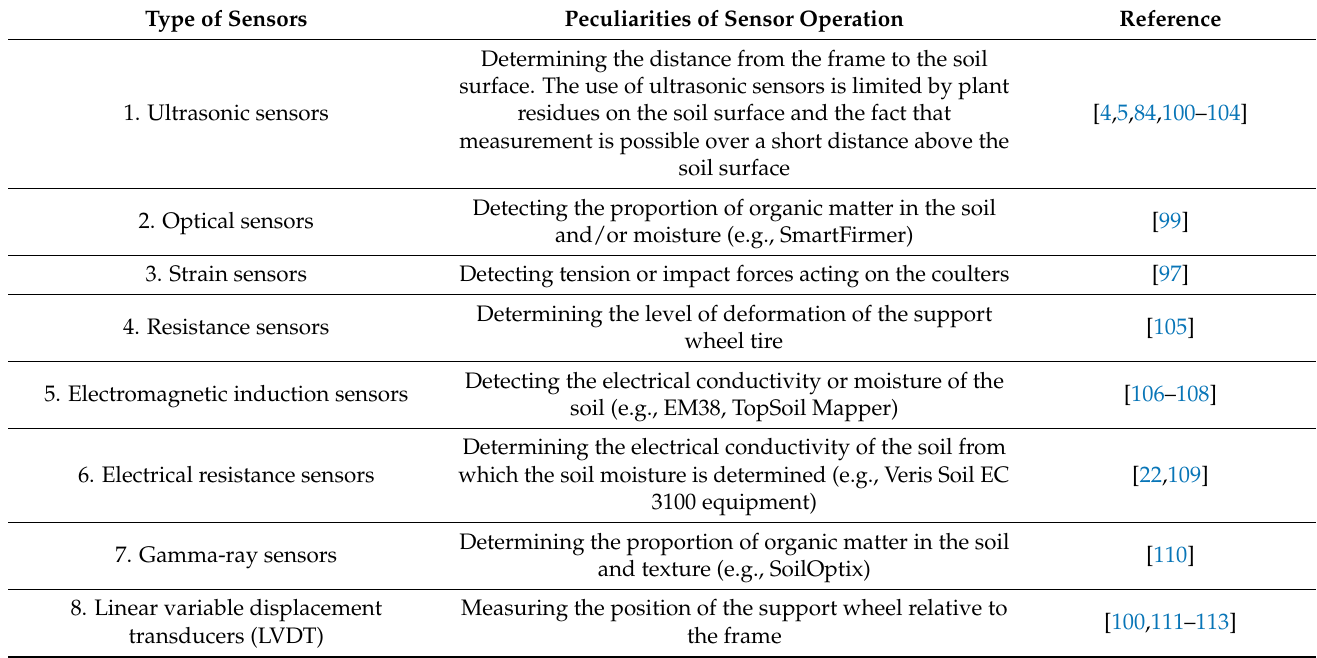
Table 4. Types of sensors and their operation